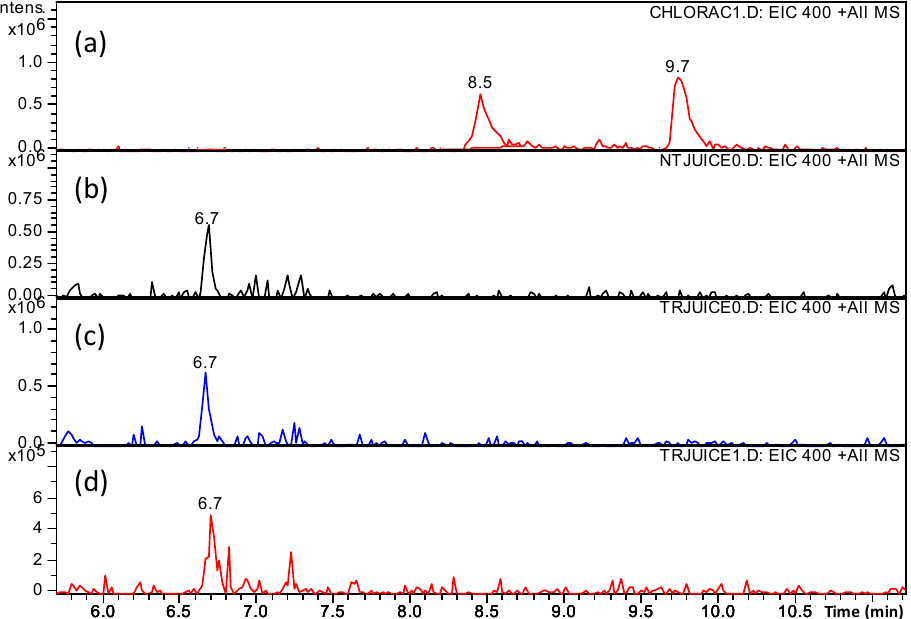
Figure 7. Extracted ion chromatograms of the signal at m / z 400 in the ( a ) batch system (BS)-treated chlorogenic acid solu- tion, ( b ) untreated juice, ( c ) electrospray system (ES)-treated juice, and ( d ) BS-treated juice. The peaks at 8.45 and 9.7 min correspond to nitrated chlorogenic acid.